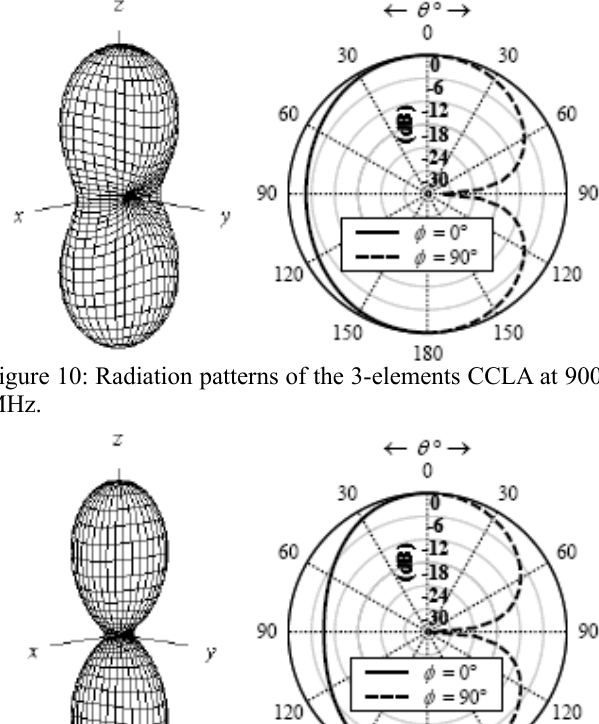
Figure 9: The effect of b of 4-elements CCLA.